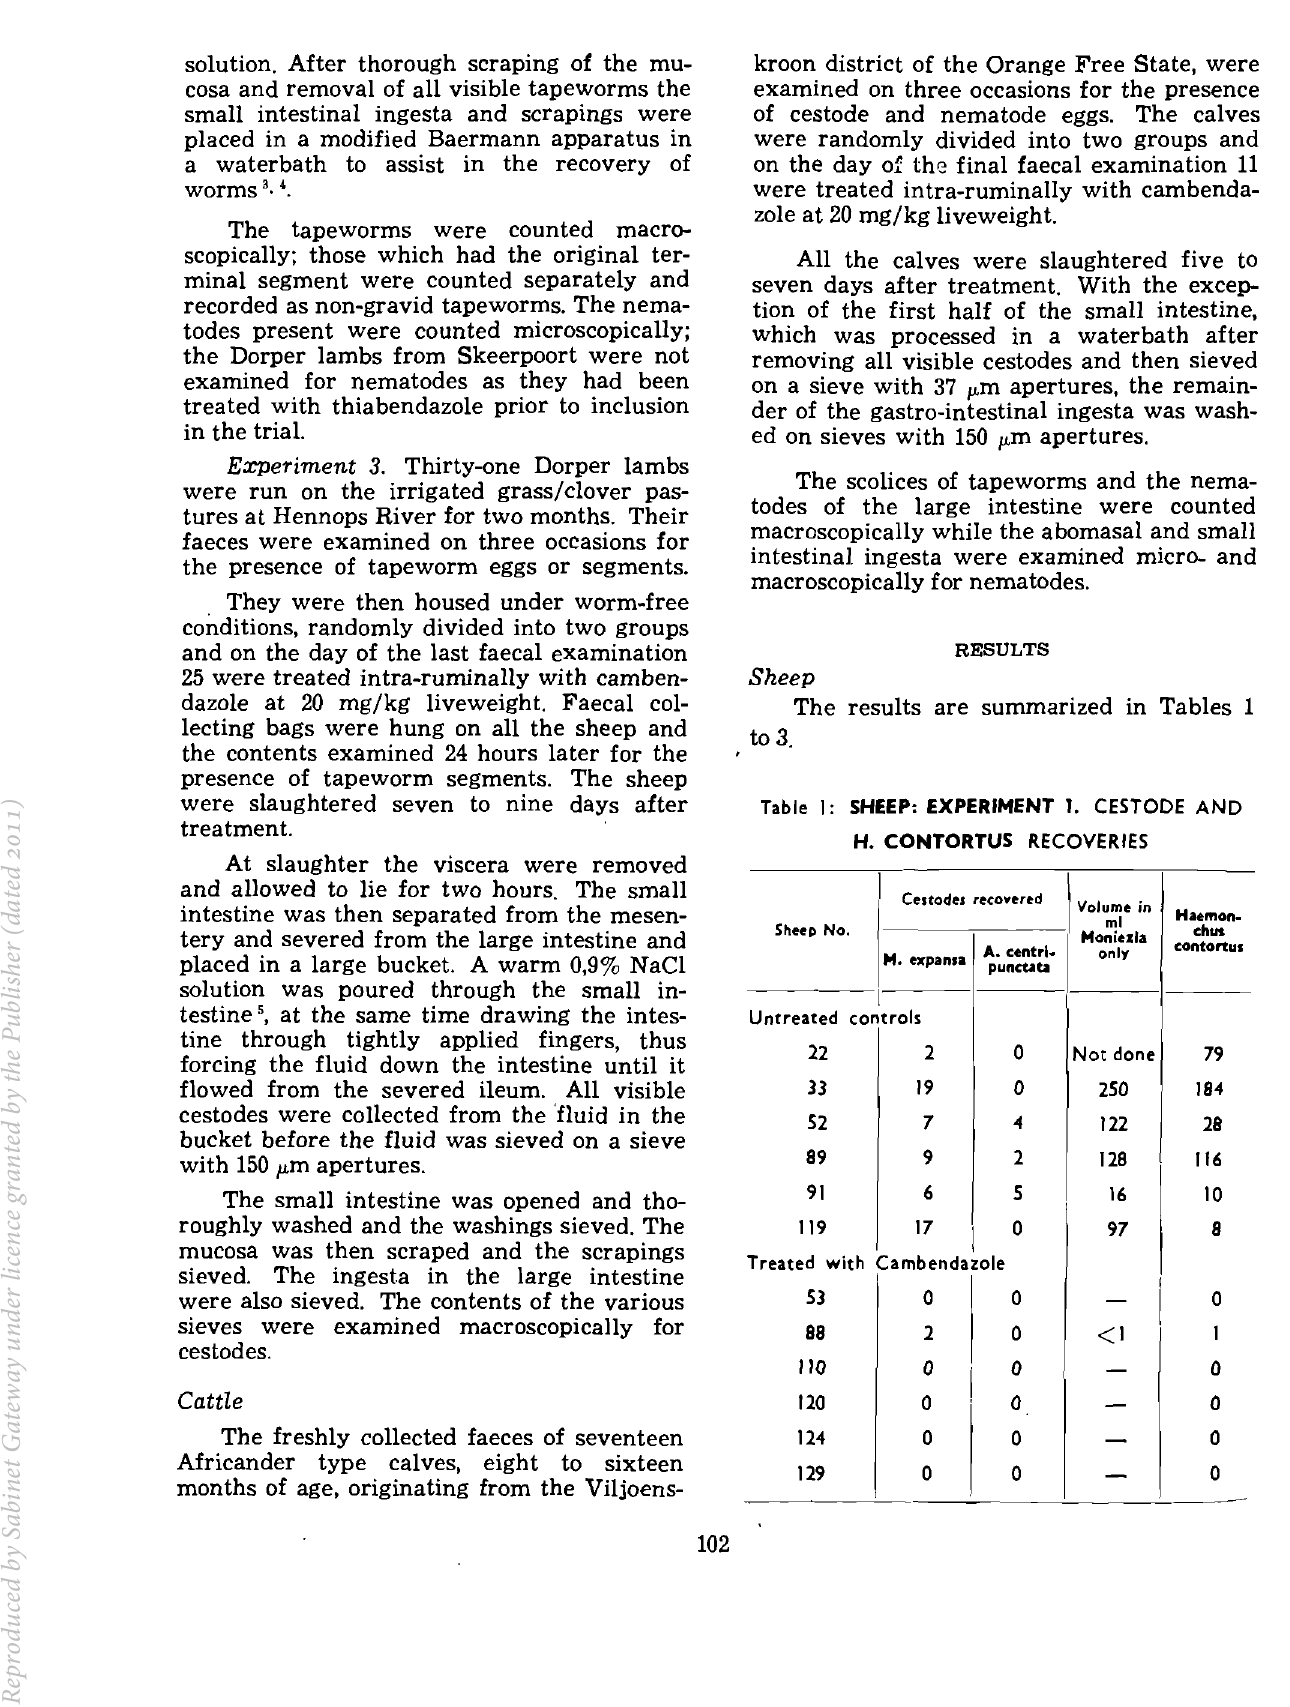
Table 1: SHEEP: EXPERIMENT 1. CESTODE AND H. CONTORTUS